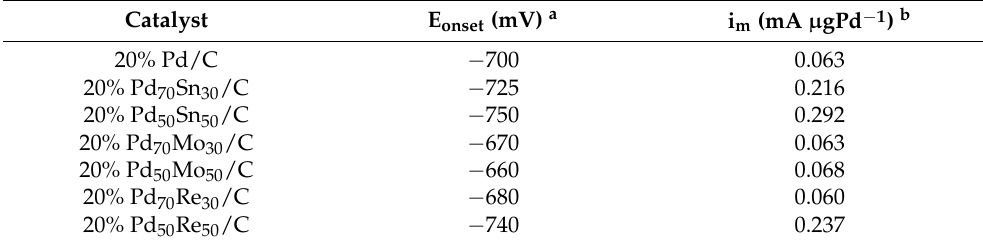
Table 2. Main electrochemical parameters for the different catalysts studied obtained from